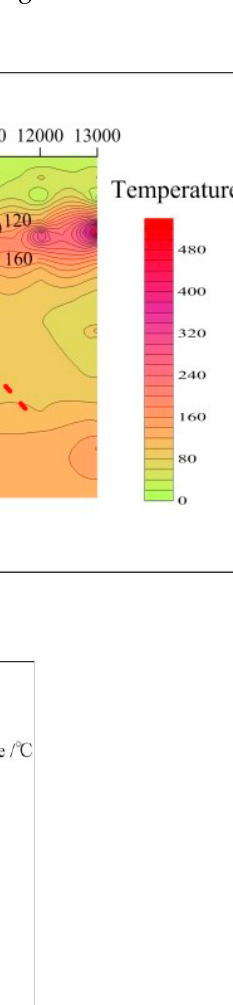
Figure 10. Temperature profile of survey line L3.